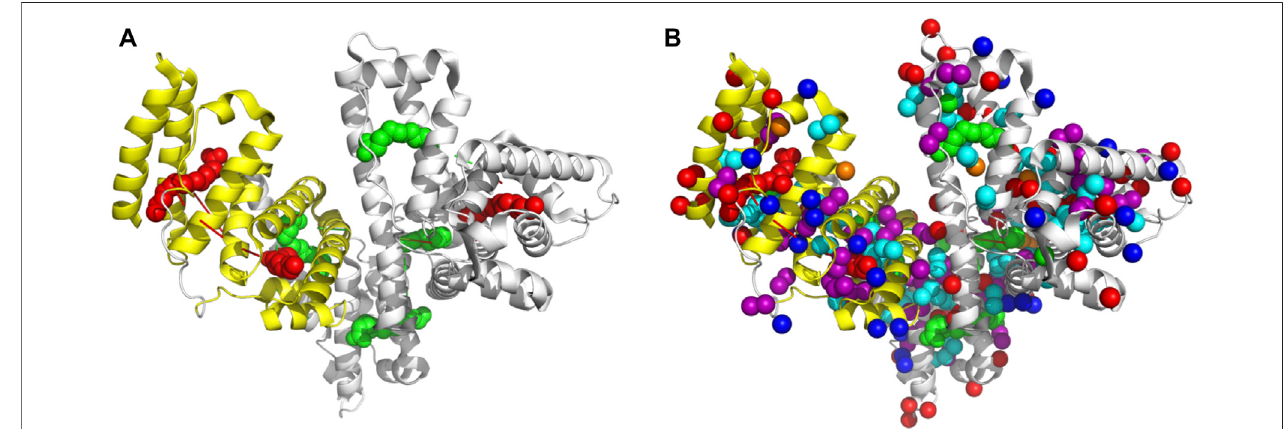
FIGURE5 | Figure (A) reperentsHSA structurebound withhexadecanoic acid or palmitic acid (PDB ID: 1E7H). Thehigh-af fi nity (red) sites and low-af fi nity sites are highlighted (green). In fi gure (B) , the Methyl groups are highlighted.